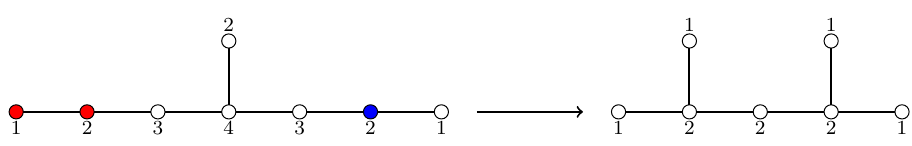
Figure 2. The SO(12) -preserving FI deformation of the rank 1 E 7 theory. This corresponds to turning on the gauge coupling in 5d. We turn on FI parameters at the red nodes, and we indicate in blue the node of the E 7 quiver which is not higgsed but is connected to a higgsed node. The extra U(1) node is coupled to the blue node